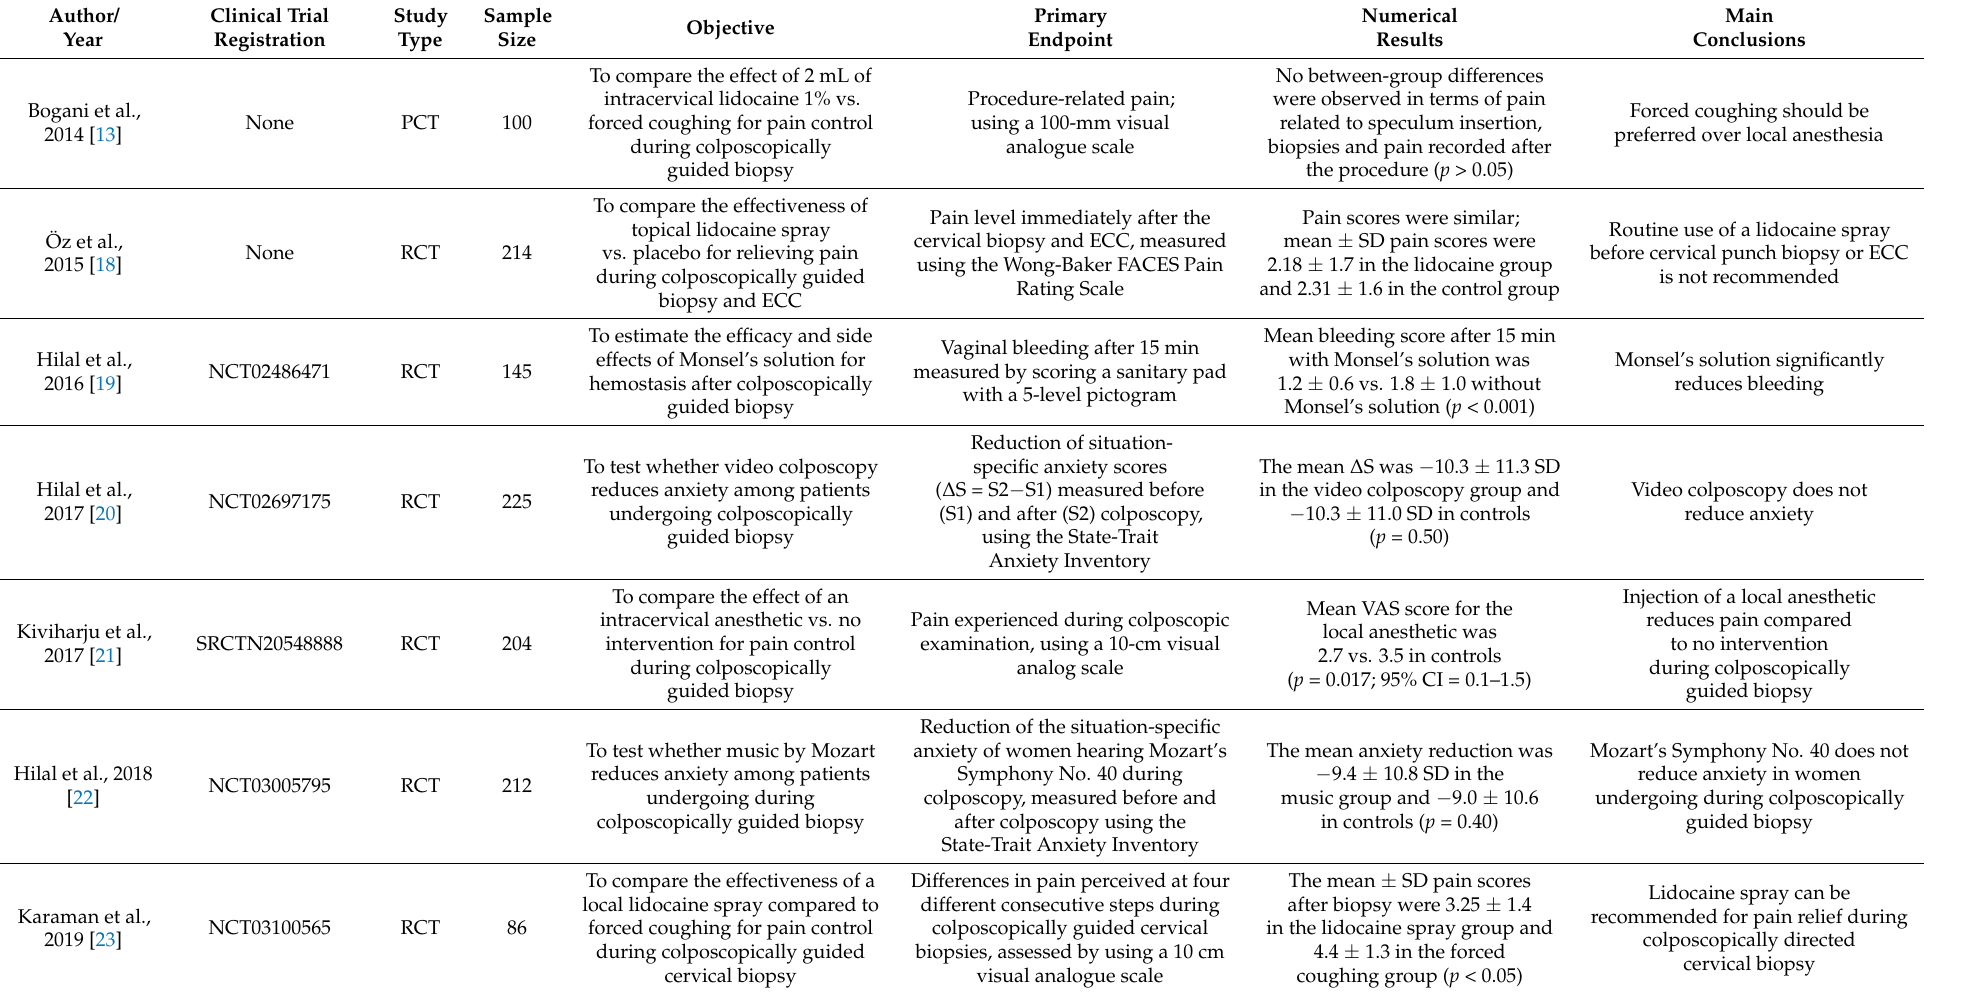
Table 1. Clinical characteristics of studies reporting on diagnostic procedures in women with cervical